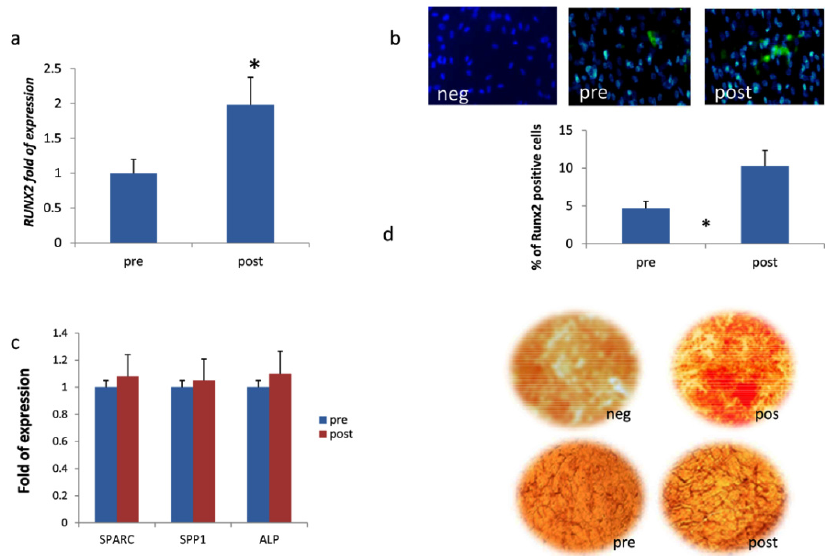
Figure 2. ( a ) RUNX2 gene expression and ( b ) protein expression in hMSCs co-cultured with human umbilical vein endothelial cells (HUVEC) and patients’ sera before (pre) and after (post) three months of DOAC treatment. ( c ) SPARC , SPP1, and ALP expression and ( d ) Alizarin red staining in the same setting of cells to evaluate osteogenic maturation; neg [wo RUNX2 antobody; ( b )] [undifferentiated hMSC; ( d )]; pos (ascorbic acid treated-MG63 cells). Magnification in ( b ) 10 × and ( d ) 4 × . * p < 0.05.